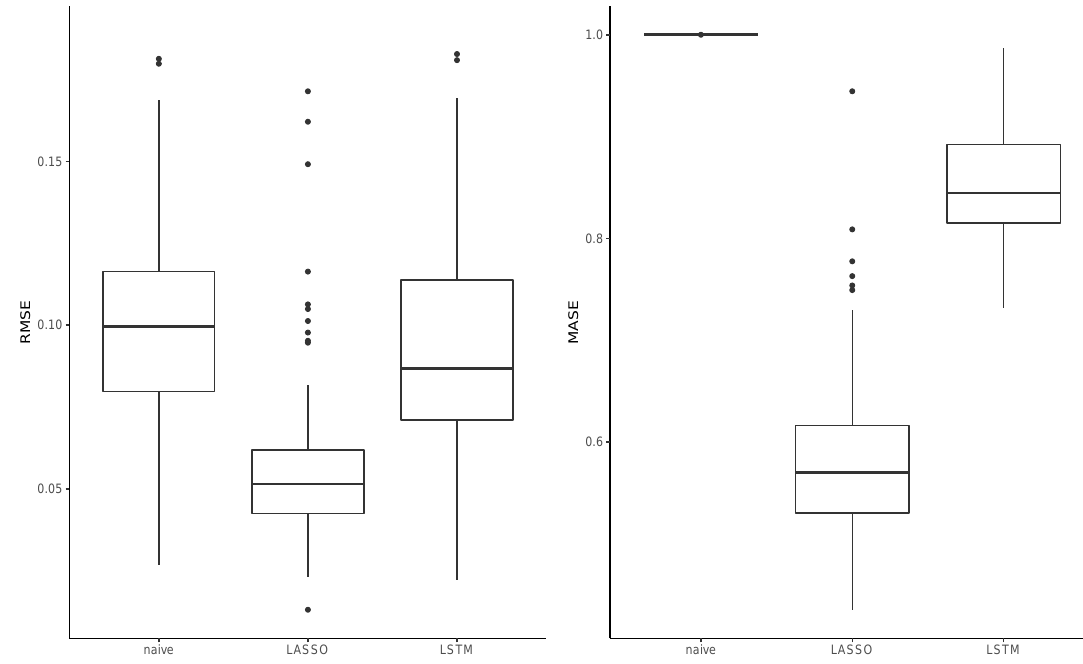
Figure 5. Box plots of RMSE and MASE scores across 88 consumer datasets for the three different prediction models (the upper 3%-quantile of the error measures is cut off for better readability). BLEMevaluateEnergyPreds (github.com/QuantLet/BLEM/tree/master/BLEMevaluateEnergyP